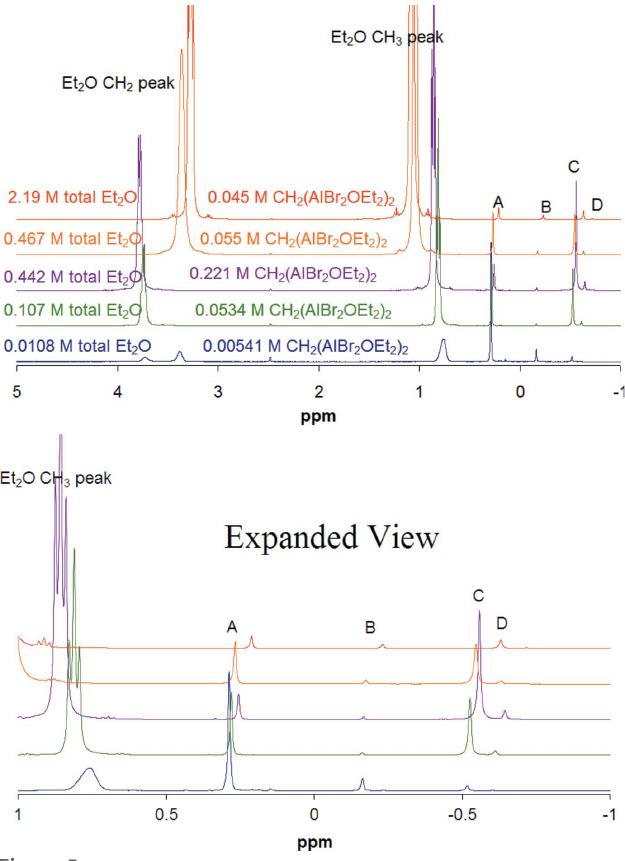
Figure 5 1 H NMR spectra of the title compound in C concentrations (bottom three spectra), and at an intermediate concen- tration with added ether (top two spectra). The CH 2 group attached to Al has peaks A , B , C , and D , which are concentration dependent, and an expanded view from (cid:3) 1 to (cid:5) 1 ppm is shown in the lower part of the figure. The concentration of the small peak at 2.5 ppm (probably OH) is invariant in all samples and is undoubtedly due to hydrolysis caused by the release of a small amount of water during flame sealing of the NMR